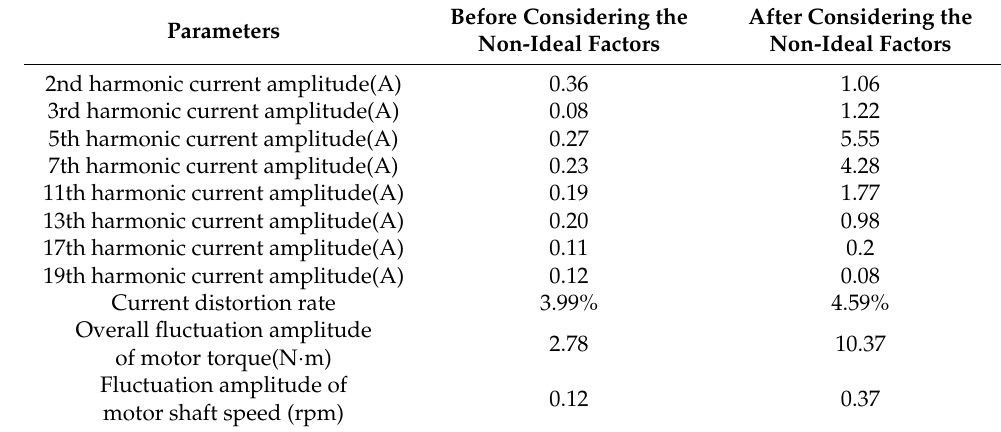
Table 6. Data comparison before and after considering the non-ideal